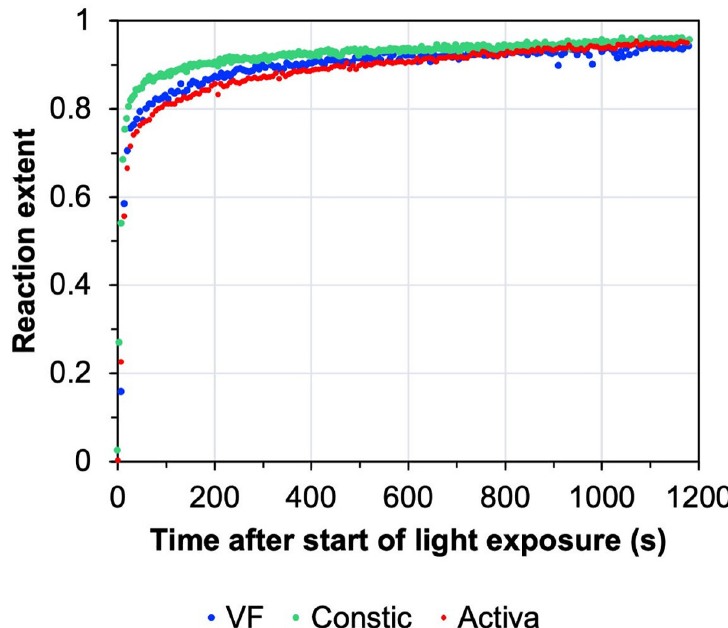
Fig 4. Reaction extent for VF, Constic and Activa. Graph indicates how far the reaction has gone towards its final value at each given time point. Reaction extent reaches 95% of the final value (determined by extrapolation of data versus inverse time to zero) by 1200 s for all the